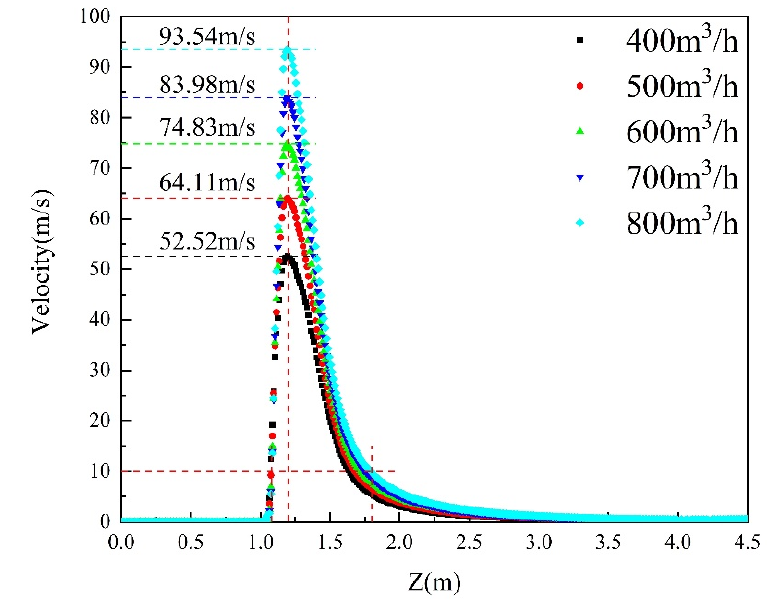
Figure 7. Velocity of the casting slab surface under different oxygen flow rates.